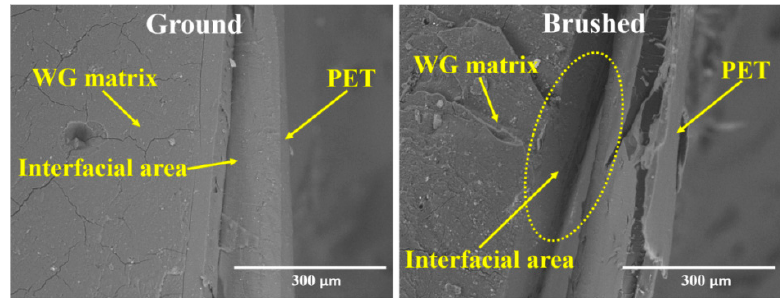
Figure 14. SEM micrographs of the tensile fractured surfaces.